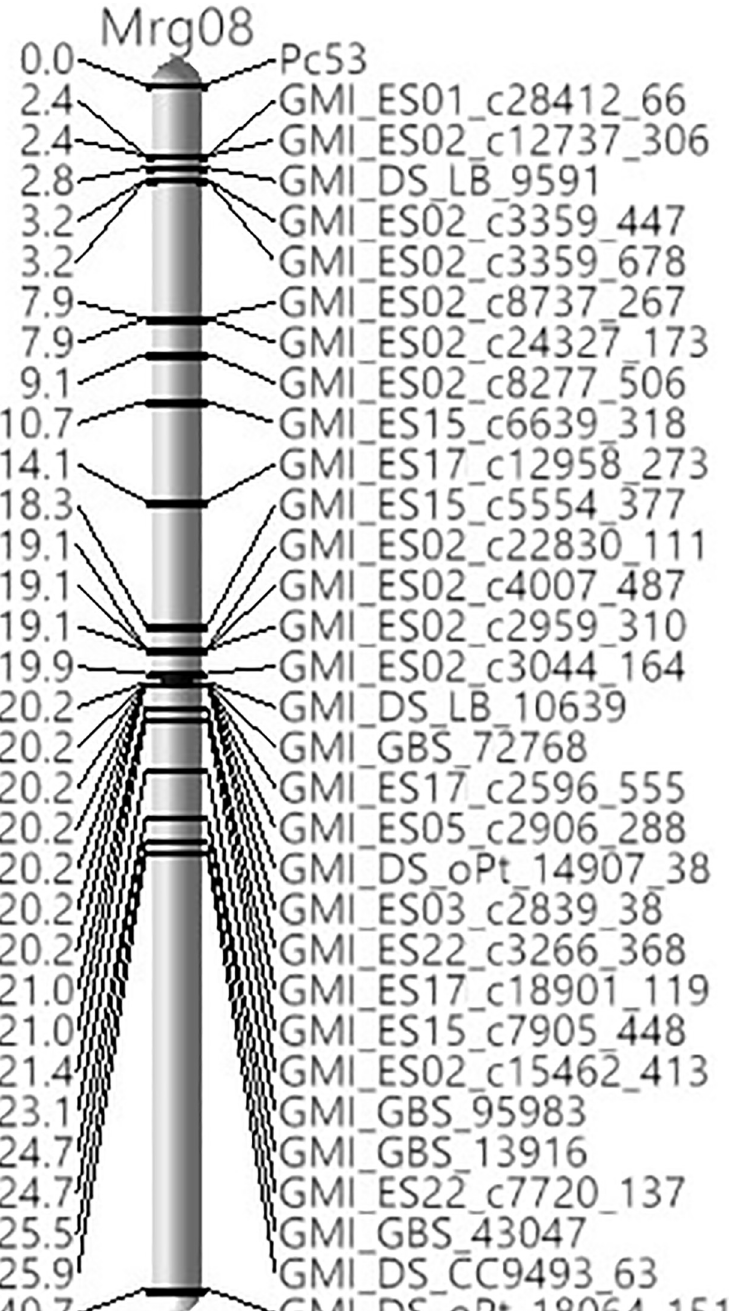
Fig 1. Genetic linkage map of Pc53 constructed with SNPs and oat F 5:6 RILs derived from a cross between Pc53 x Otana. The linkage group Mrg08 is based on the oat consensus map of Chaffin et al. [23].